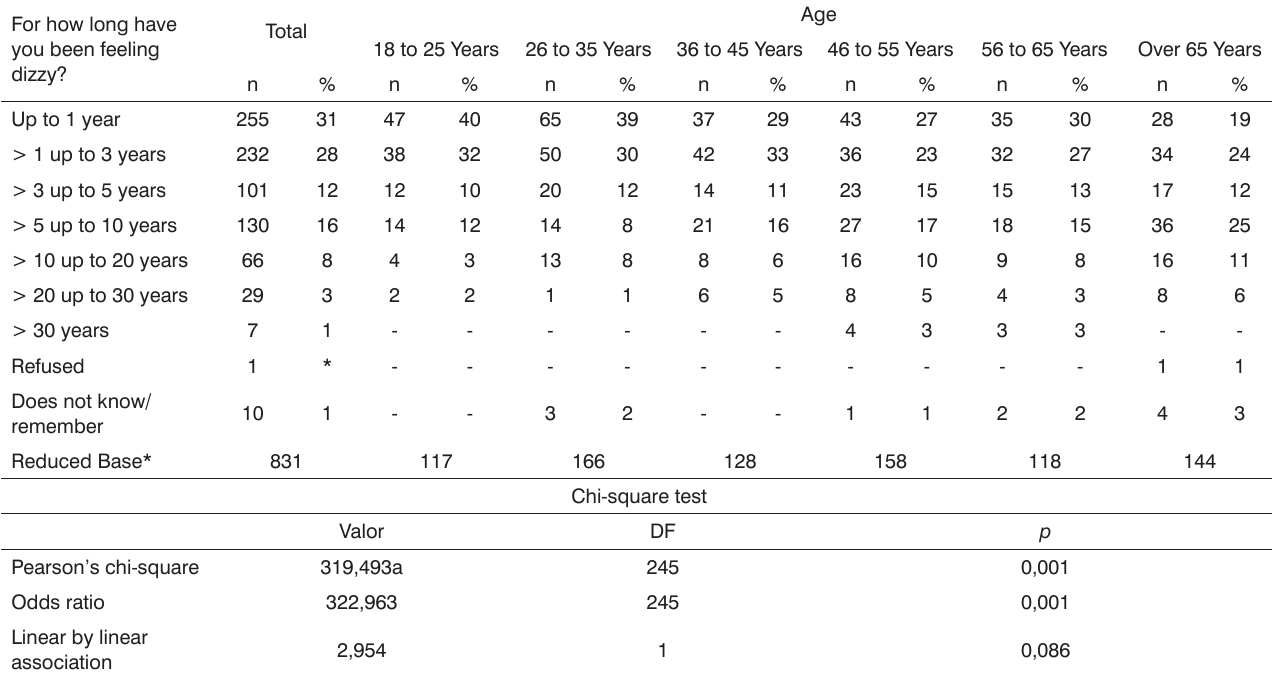
Table 5. Distribution of “feeling dizzy” complaint along time (n = 831) according to the different age groups in the population of the city of São Paulo.